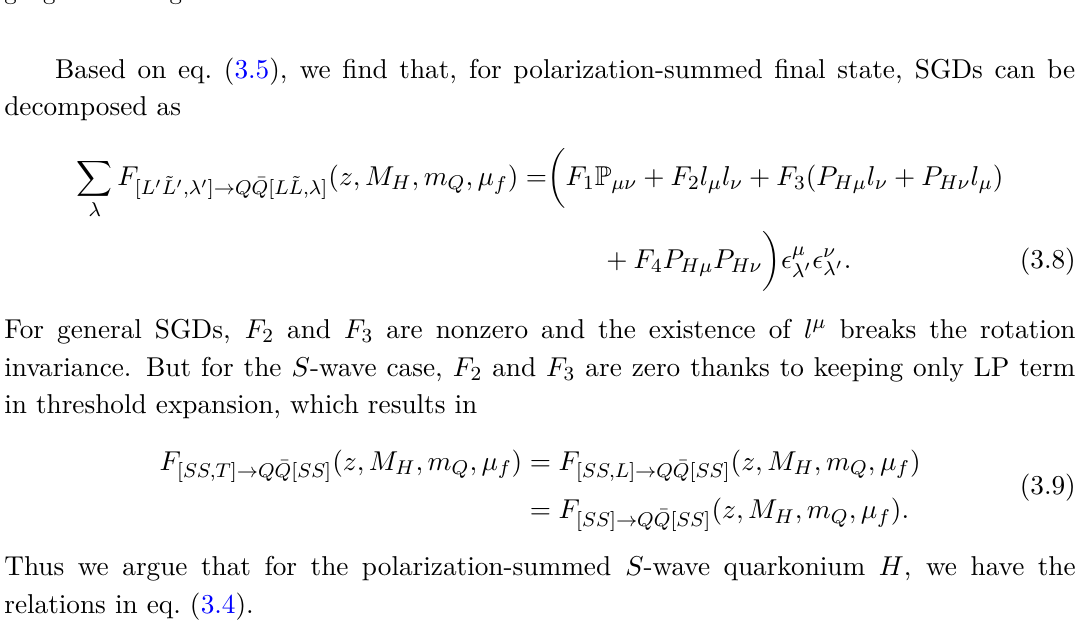
Figure 1 . Feynman diagrams for the free Q ¯ Q SGD at LO. The double solid line represents the gauge link along l